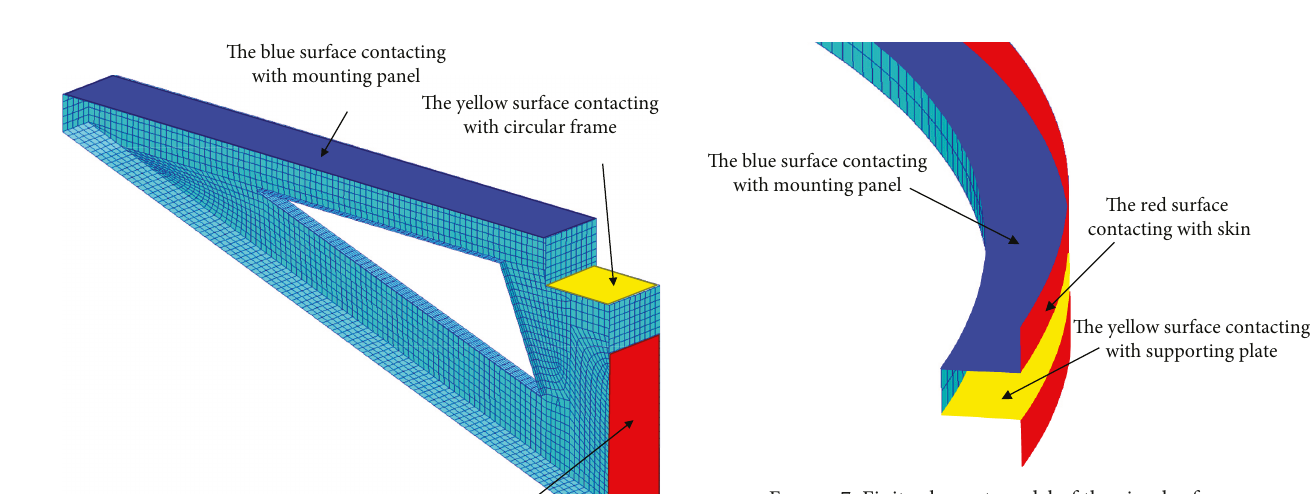
Figure 5: Finite element model of the inertial bracket.